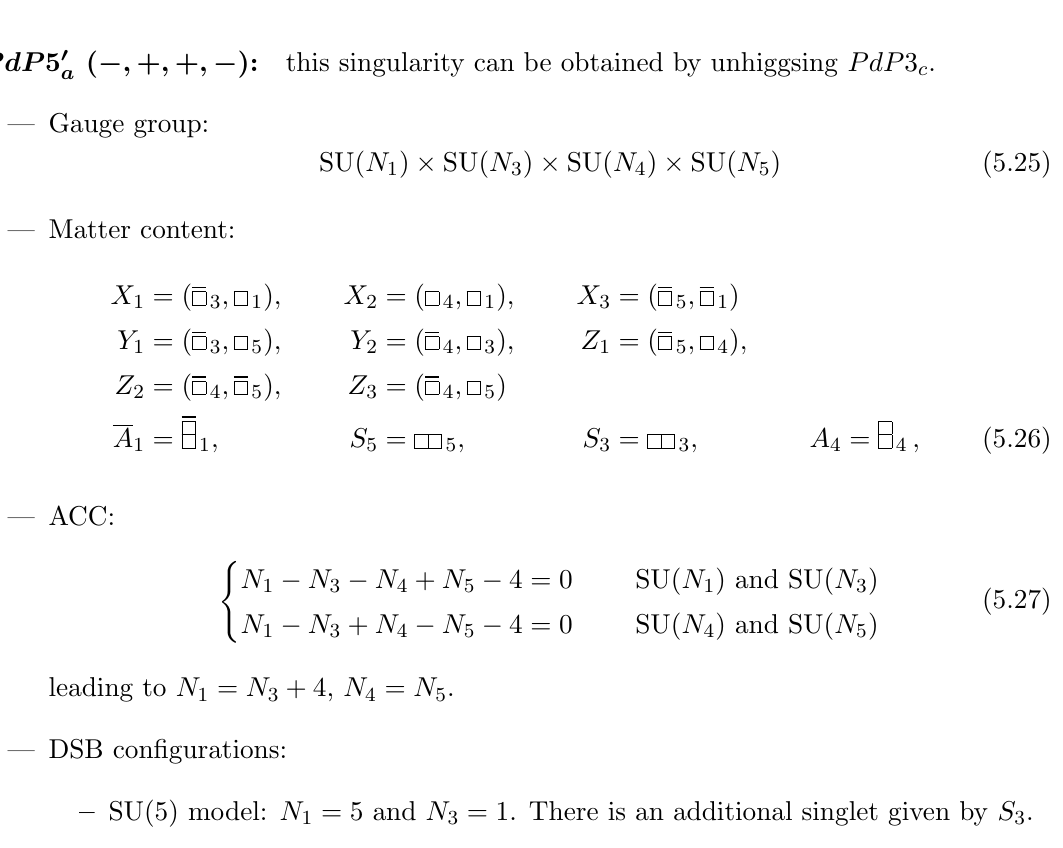
dimer with orientifold a